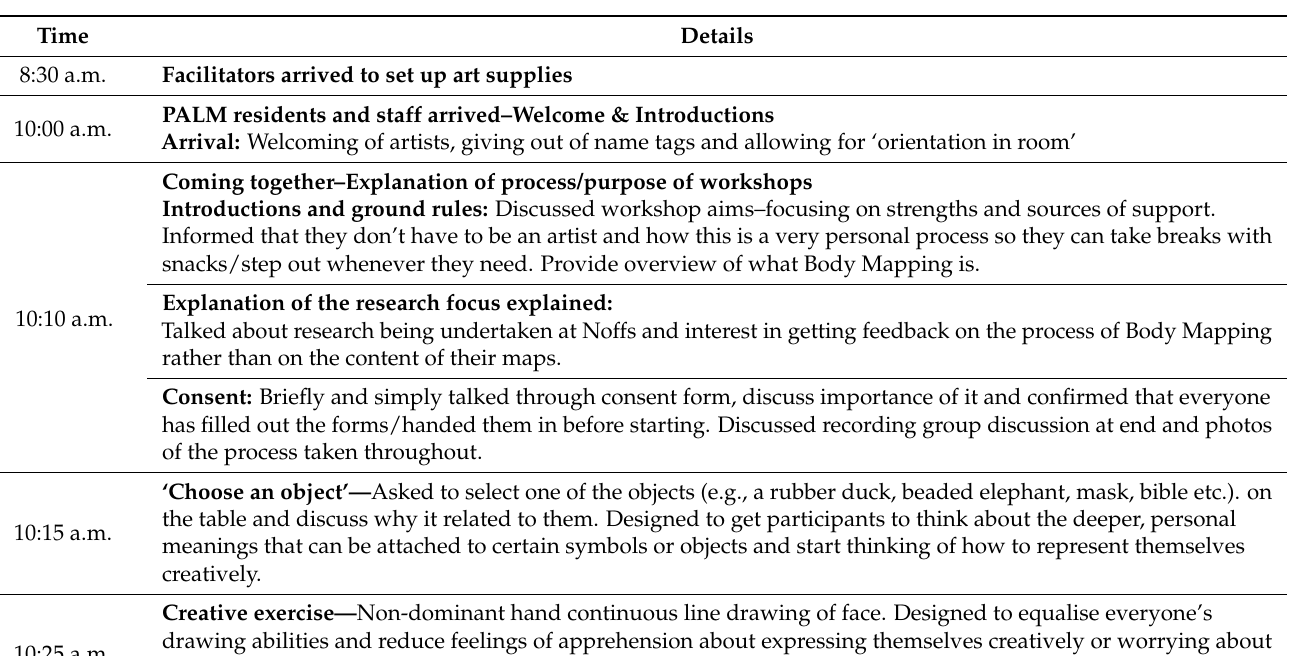
Table A1. Workshop Run Sheet and